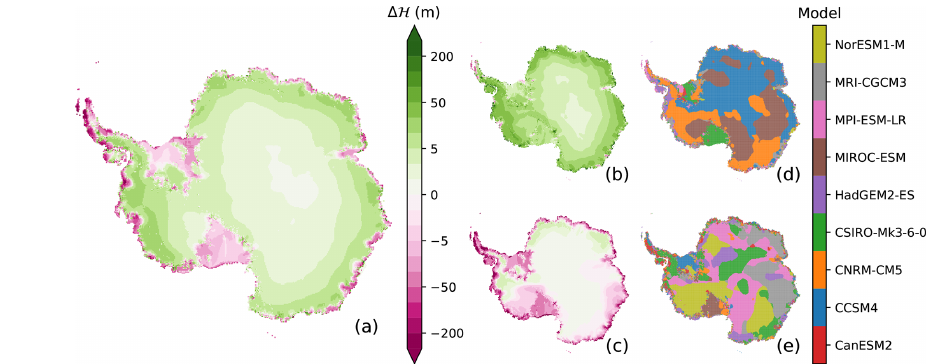
Figure 9. Ice thickness changes since 1850 under the RCP8.5 scenario for the precipitation anomaly that was actually applied in the year 2100. Highlighted are the ensemble mean (a) , ensemble maximum (b) , and ensemble minimum (c) . The climate models that were used to drive the ice sheet model simulation causing the maximum and minimum thickness are shown in panels (d) and (e) , respectively, next to the ensemble maximum (b) and minimum (c)